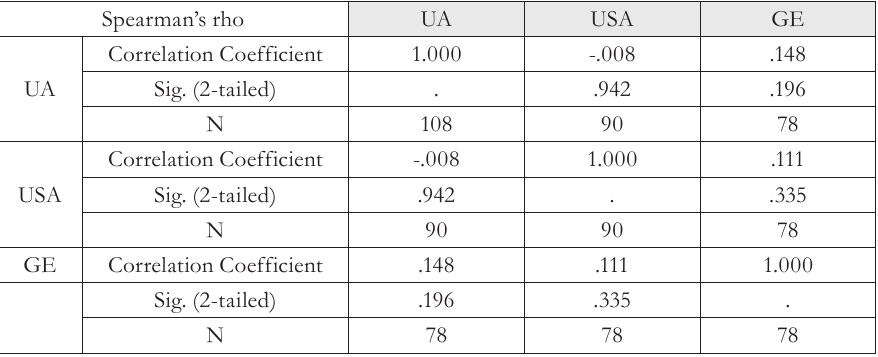
Tab. 10 - Correlations between countries according to the religion (Spearman’s coefficient). Source: authors’ research.